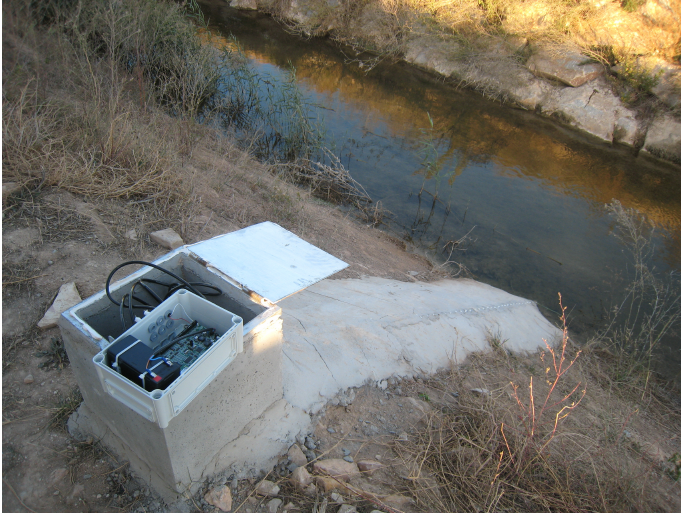
inserted into a 400 × 400 cm cement housing. The housing has 70 cm diameter hole that connects a 65 cm diameter and 7 m length PVC pipe, which protects the UNIK-5000 sensor.